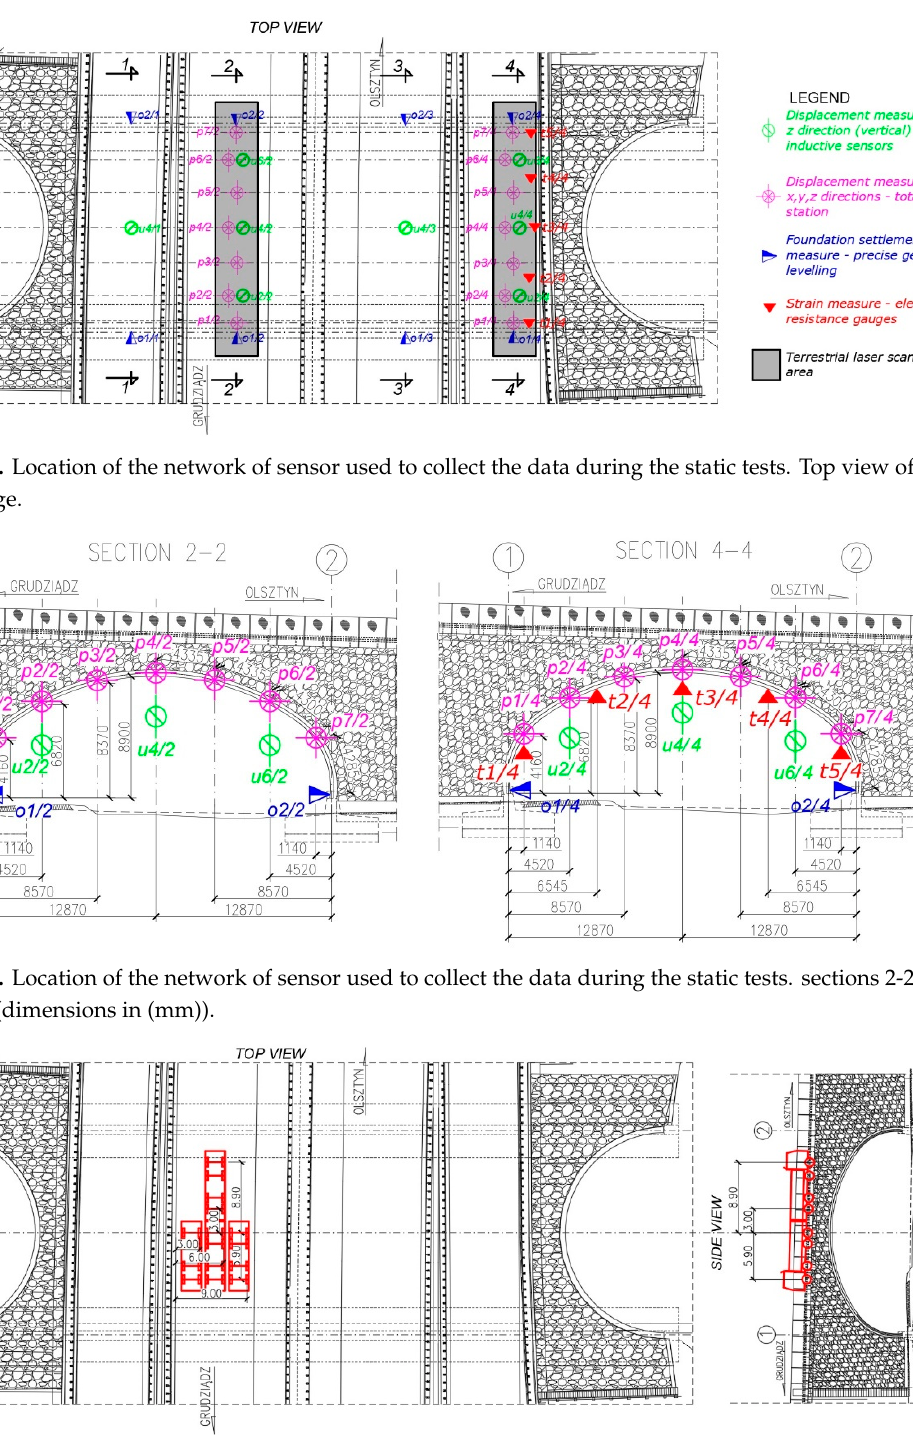
Figure 7. Schematic drawing of trucks locations during the S1 test configuration (dimensions in (m)).